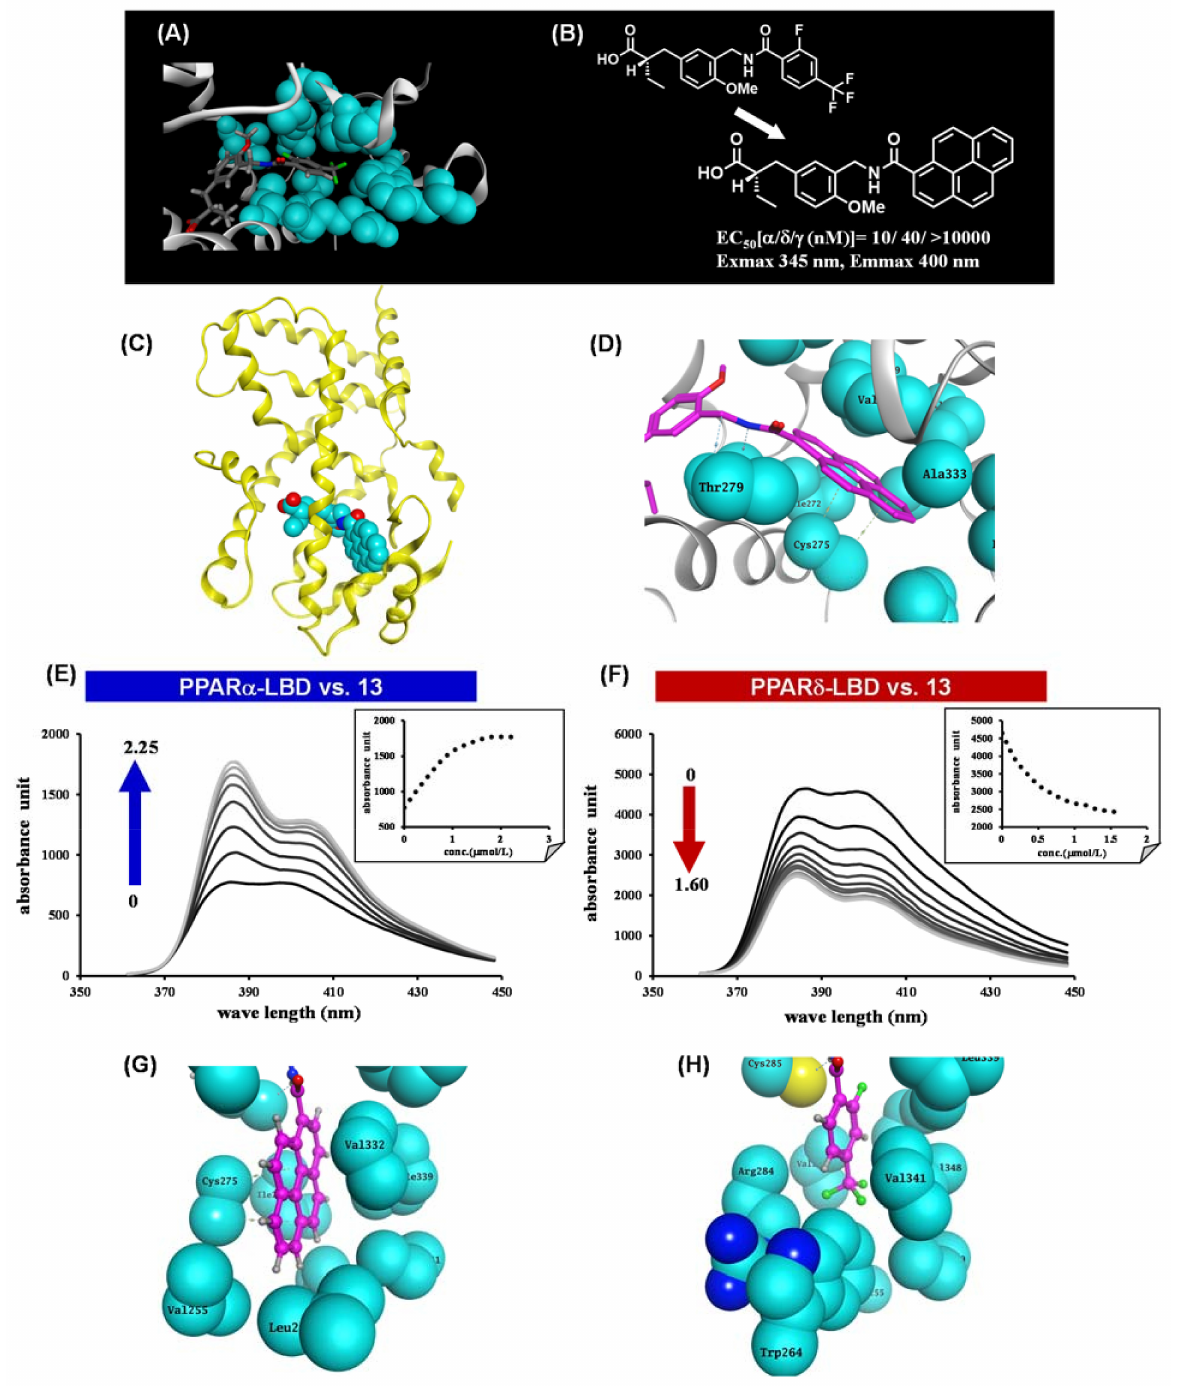
Figure 11. ( A ) Zoomed view of the hydrophobic tail of TIPP-401 complexed with the human PPAR α LBD. ( B ) Structural design of APHM-13. ( C ) X-ray crystallographic structure of APHM-13 complexed with the human PPAR α LBD. ( D ) Zoomed view of the hydrophobic tail of APHM-13 complexed with the human PPAR α LBD. ( E ) Fluorescence polarization value changes with the addition of human PPAR α to APHM-13 in PBS. ( F ) Fluorescence polarization value changes with the addition of human PPAR δ to APHM-13 in PBS. ( G ) Zoomed view of the hydrophobic interaction of the pyrene ring of APHM-13. ( H ) Zoomed view of the hydrophobic interaction of the 2-fluoro-4-trifluorophenyl ring of